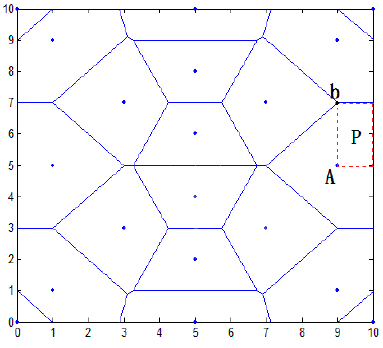
Figure 11. Determining the range of unknown node coordinates.